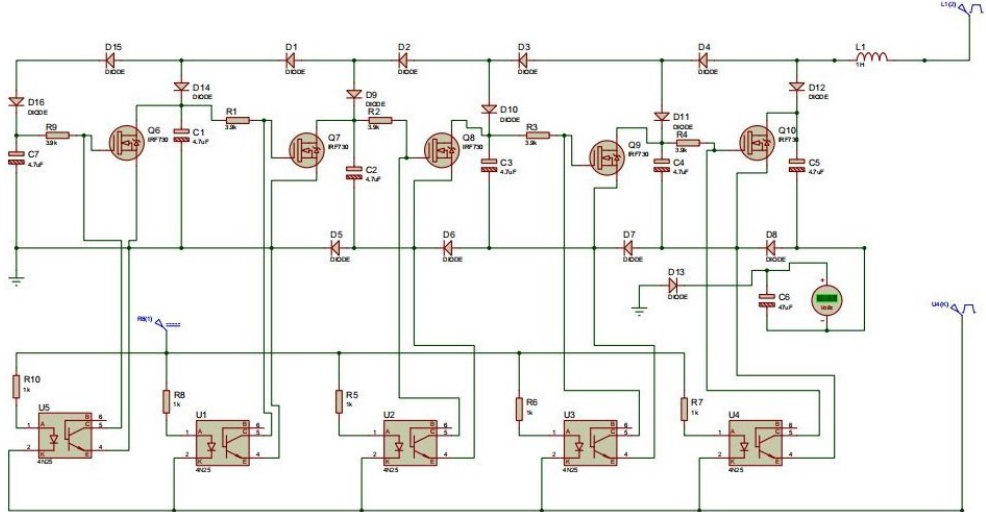
Figure 7. Circuit diagram of the modified Marx pulse generator circuit with an